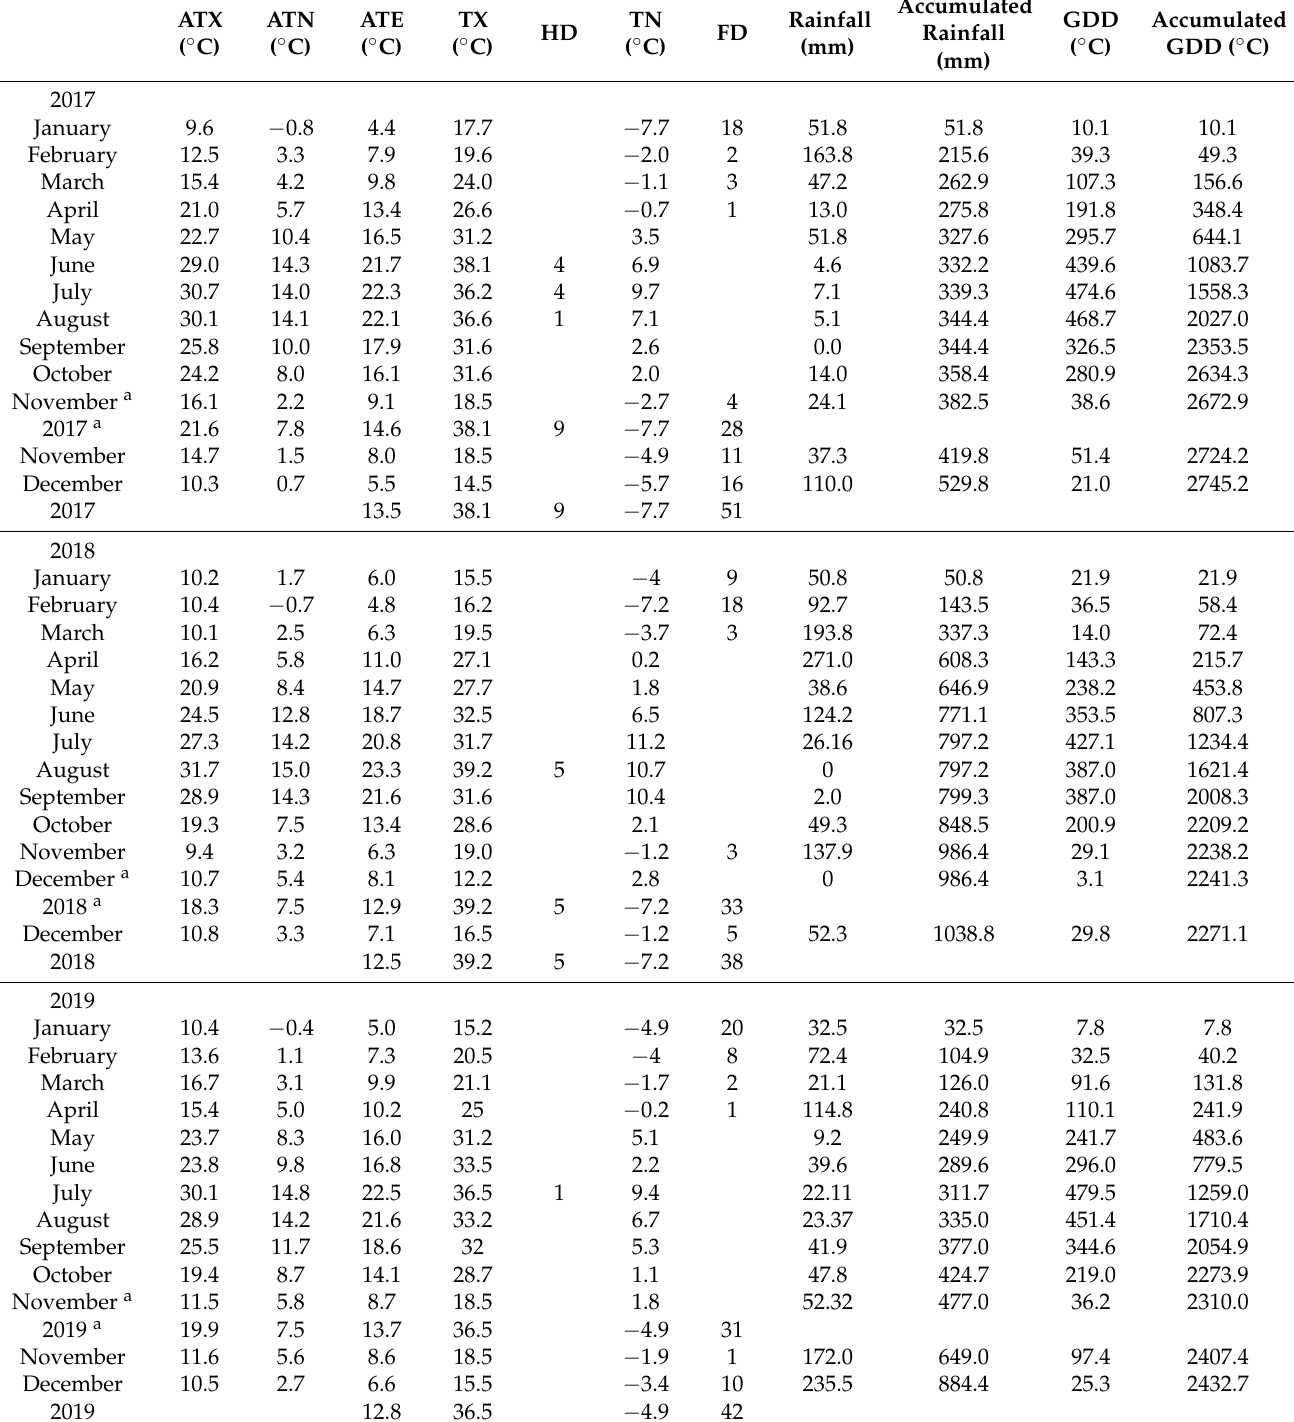
Table 5. Average monthly temperature (maximum, ATX, minimum, ATN, and mean, ATE), maximum (TX) and minimum (TN) air temperature, number of hot days (HD, maximum temperature above 35 ◦ C) and frost days (FD, minimum temperature below 0 ◦ C), precipitation and growing degree days (GDD, assuming that the air temperature threshold below that which the plants’ growth does not progress is 7 ◦ C [49] during the experimental period